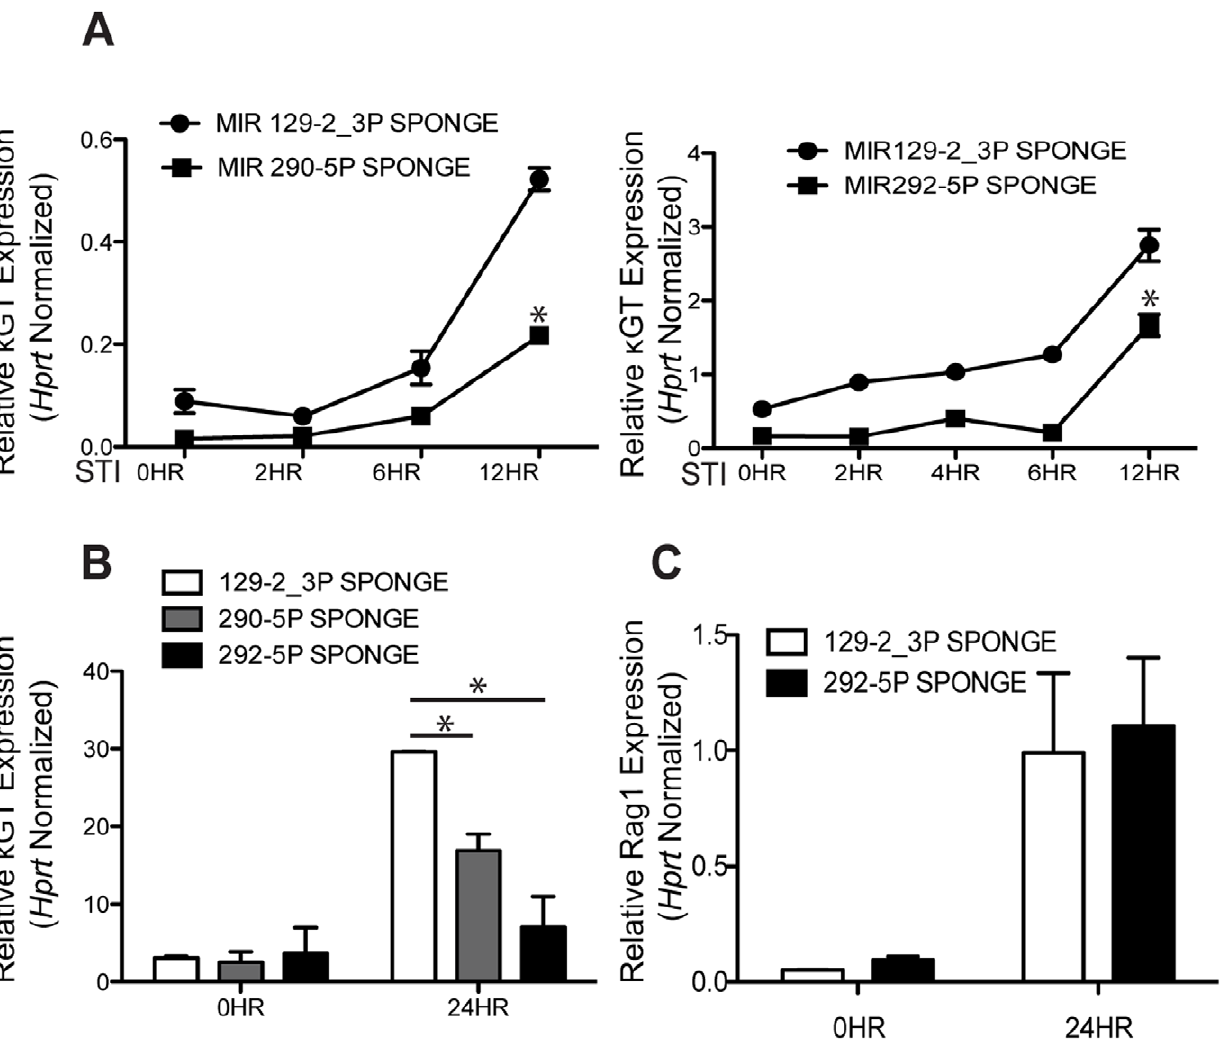
Figure 3. k GT induction is blunted upon knockdown of miR290-5p or miR292-5p. 3A. qPCR analysis of k GT expression in RNA purified from E2A + / + AMuLV cells expressing a miR290-5p or miR292-5p sponge knockdown construct, and cultured in the presence of STI571 (2.5 m M) for the indicated lengths of time. Data was normalized to the expression of Hprt . Error bars represent range for replicate qPCR reactions. Asterisk represents P value , 0.05. The P value was derived by the Student’s T test. These data are from one representative experiment of at least four independently performed experiments. 3B, C. qPCR analysis of (B) k GT or (C) Rag1 expression in RNA purified from wild-type primary pro-B cells transduced with either a miR129-2_3p control knockdown sponge, or a miR290-5p or miR292-5p knockdown sponge. Wild-type primary pro-B cells were cultured in rIL7 (2 ng/ml) for 5 days and then transduced with indicated sponge construct. Marker positive cells were then sorted and IL7 withdrawn from culture for 24 hrs before RNA was harvested. qPCR measures (B) k GT or (C) Rag1 expression in cells before or after the withdrawal of IL7. Data was normalized to Hprt expression levels. Error bars represent range for replicate qPCR reactions. Asterisk represents P value , 0.05. The P value was derived by the Student’s T test. These data show one representative experiment of at least four independently performed